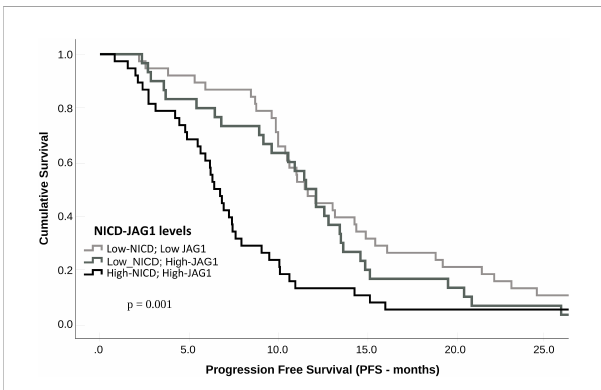
FIGURE 2 Progression-free survival (PFS) according to NICD and Jag1 expression levels in metastatic CRC patients treated with